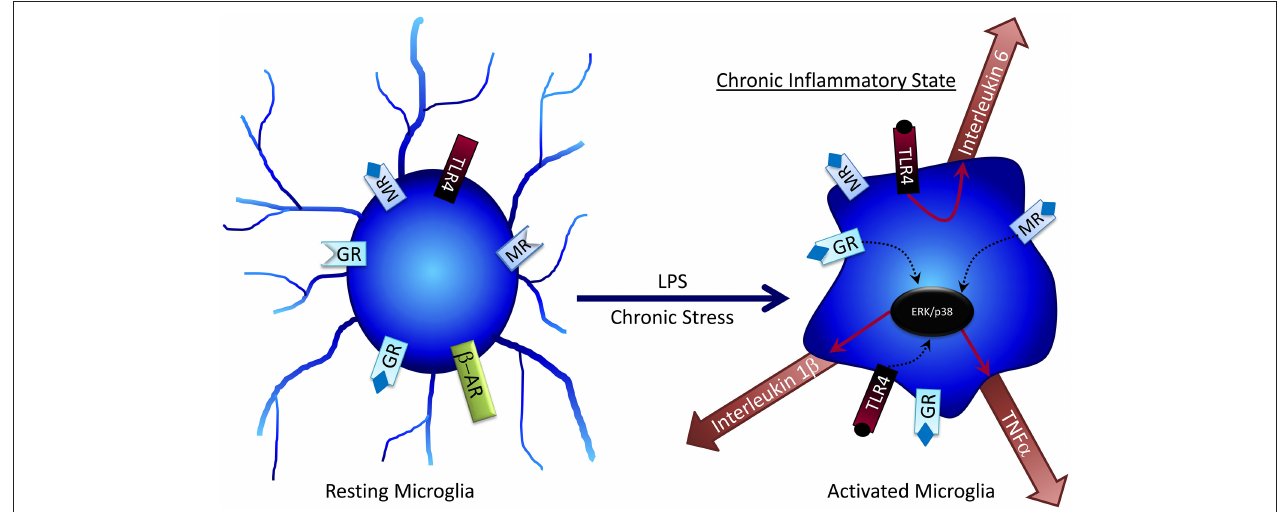
FIGURE 2 | Microglia can become activated by factors such as LPS or chronic stress, where they become desensitized to the anti-inflammatory effects of glucocorticoids. Activated microglia can release pro-inflammatory cytokines, which at high concentrations can have negative effects on cognitive